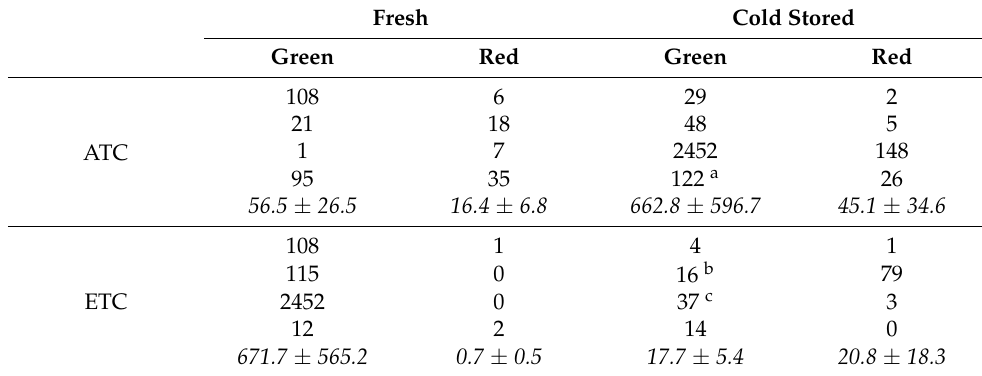
Table 1. Alternaria alternata genome copies and mycotoxin detection in inoculated lettuces. Fresh Cold Stored Green Red Green Red 108 6 29 2 21 18 48 5 1 7 2452 148 ATC 95 35 122